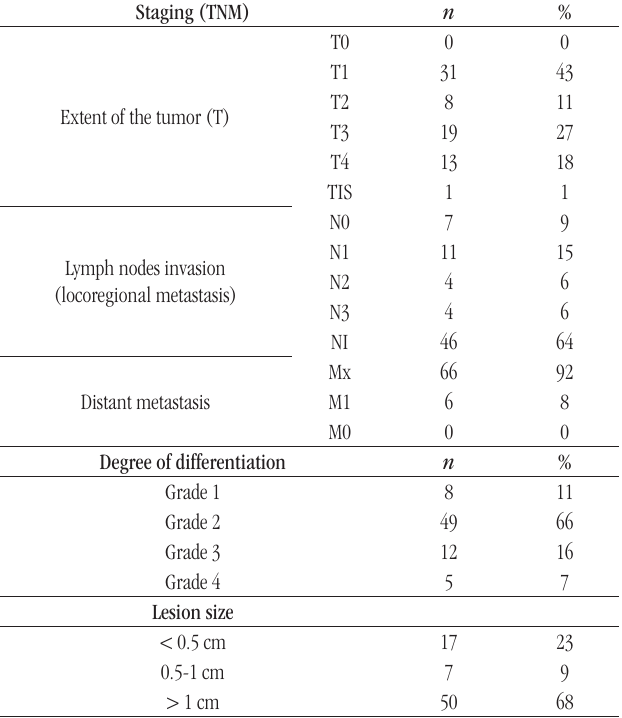
taBLE 2 − Distribution of neoplasms according to TNM staging and degree of differentiation of tumors and distribution of studied population according to lesion